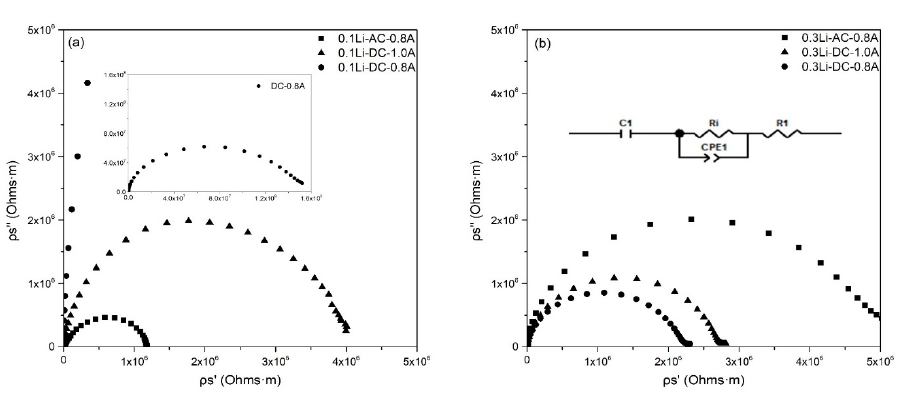
Figure 5. Room temperature impedance spectra of different samples. ( a ) 0.1Li sample impedance spectra; ( b ) 0.3Li sample impedance spectra and equivalent circuit.